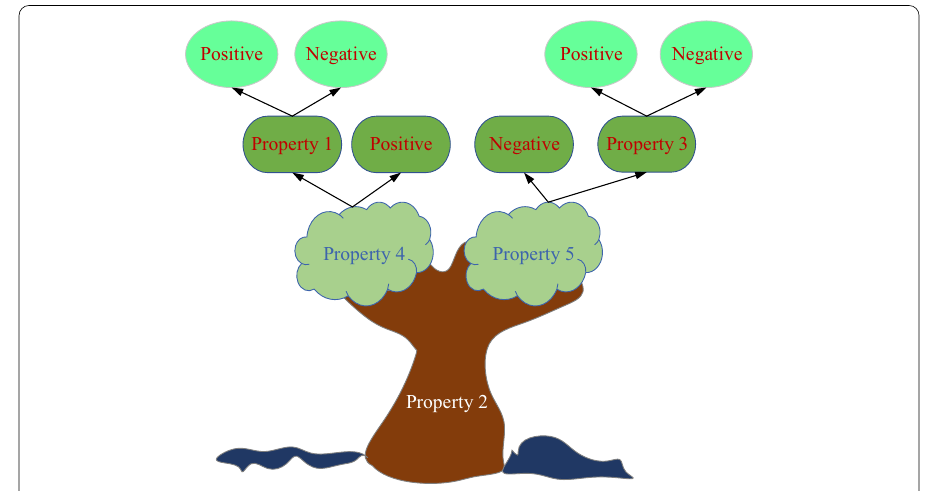
Fig. 2 Structure of the binary tree